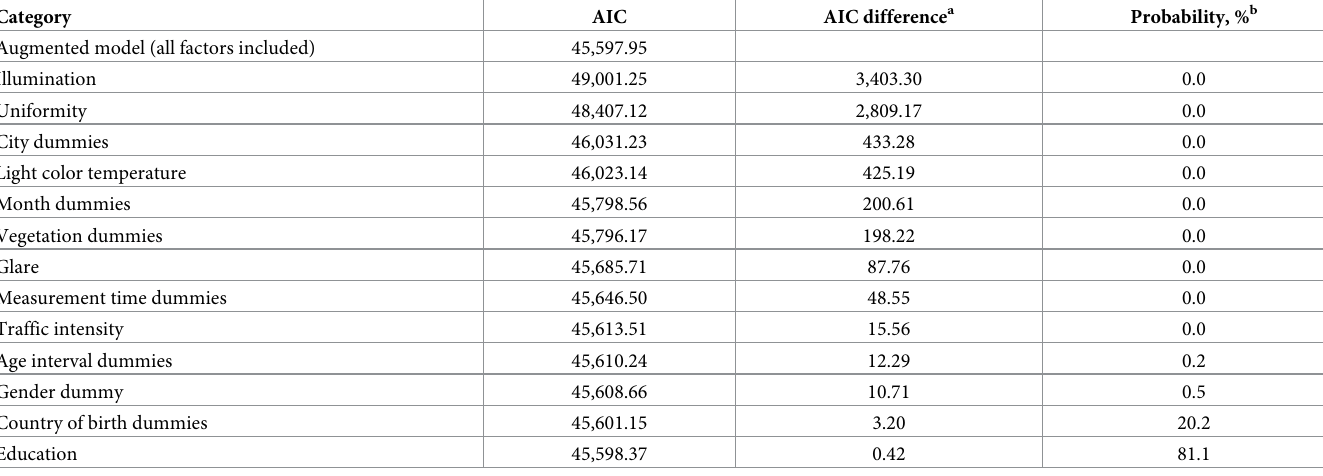
Table 6. Test of the improvement in the model’s fit attributed to the inclusion of different explanatory